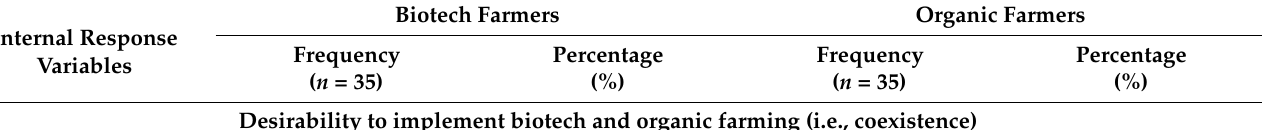
Table 2. Internal response variables a of biotech and organic